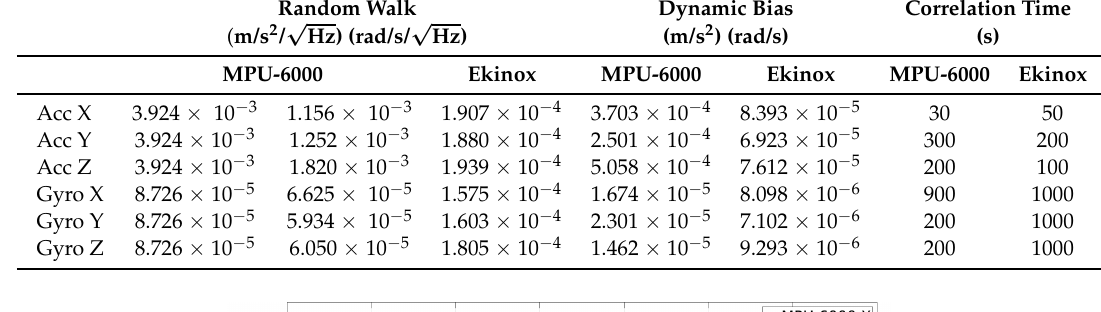
Table 2. Noise profile from Allan variance analysis for MPU-6000 and Ekinox IMUs. Random Walk